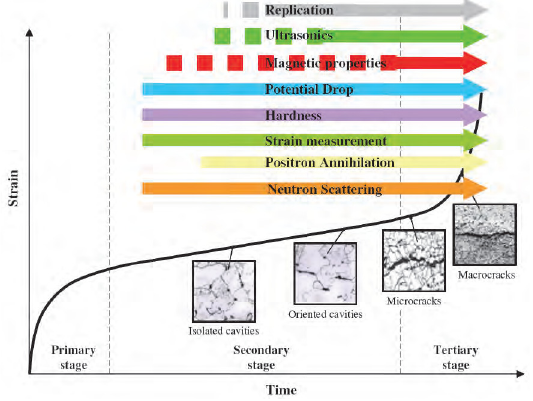
Figure 2: Application of NDT methods in detecting defects in the life of the steam line [6].